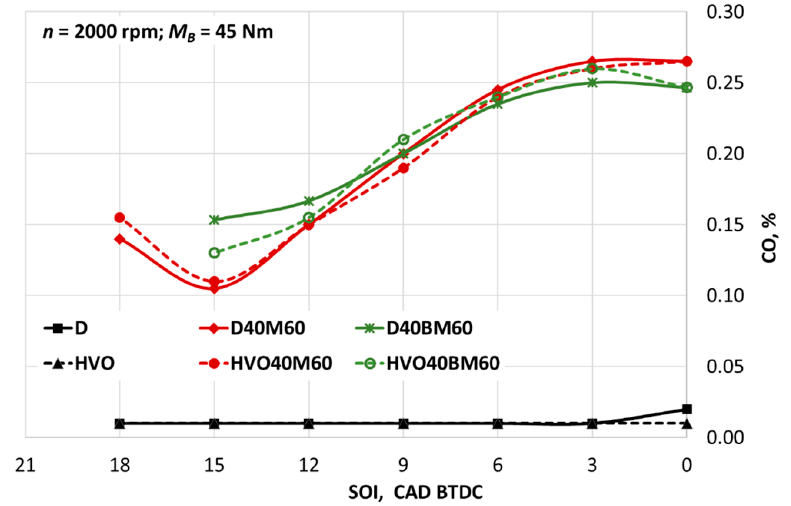
Figure 6. Change of CO volumetric fraction depending on fuel composition and SOI.